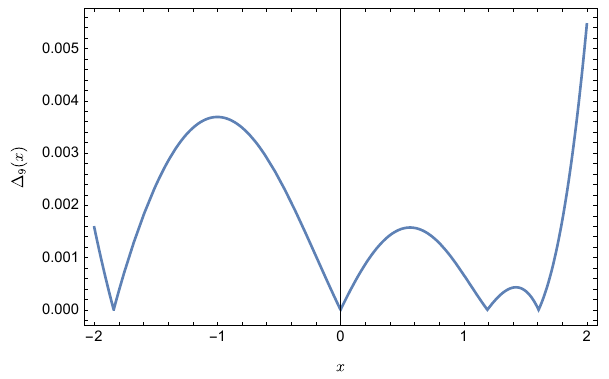
Figure 8. Error ∆ 9 of approximation y 9 ( x )